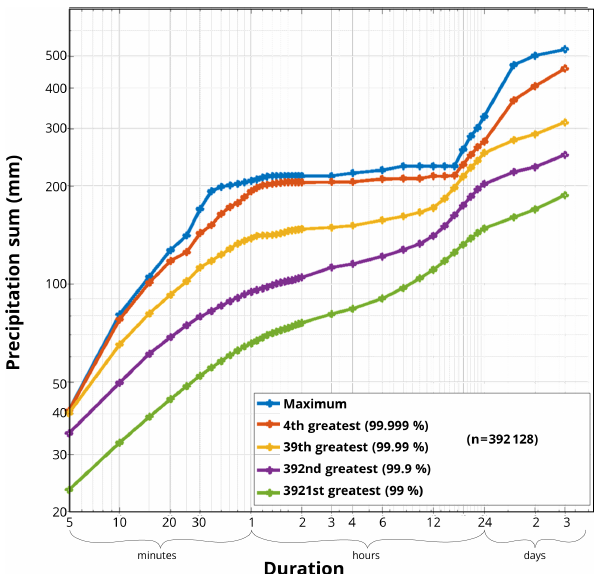
Figure 4. Depth–duration relationships of rainfall values for all of Germany based on QPE RADKLIM-YW for 2001–2016 from max- imum values down to the 3921st greatest per